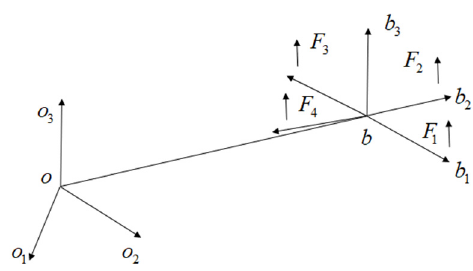
Figure 4. Schematic diagram of the relationship between the inertial coordinate system and body coordinate system.